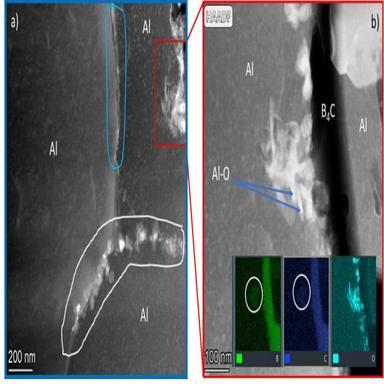
(a) Bright field micrograph of the interface between Al grains, and (b) HAADF micrograph of Al/B4C interfacial zone and B, C, and O EDX maps.